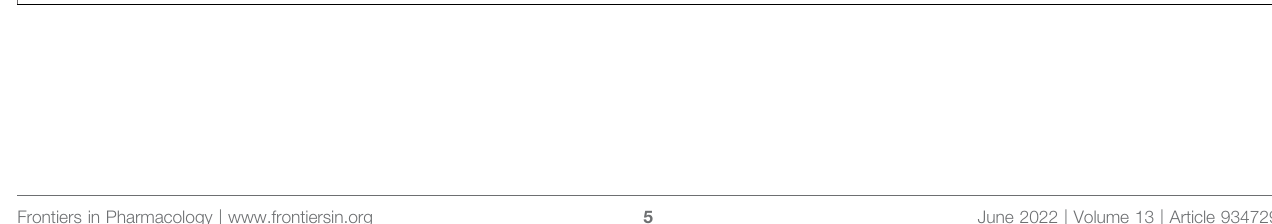
Frontiers in Pharmacology |